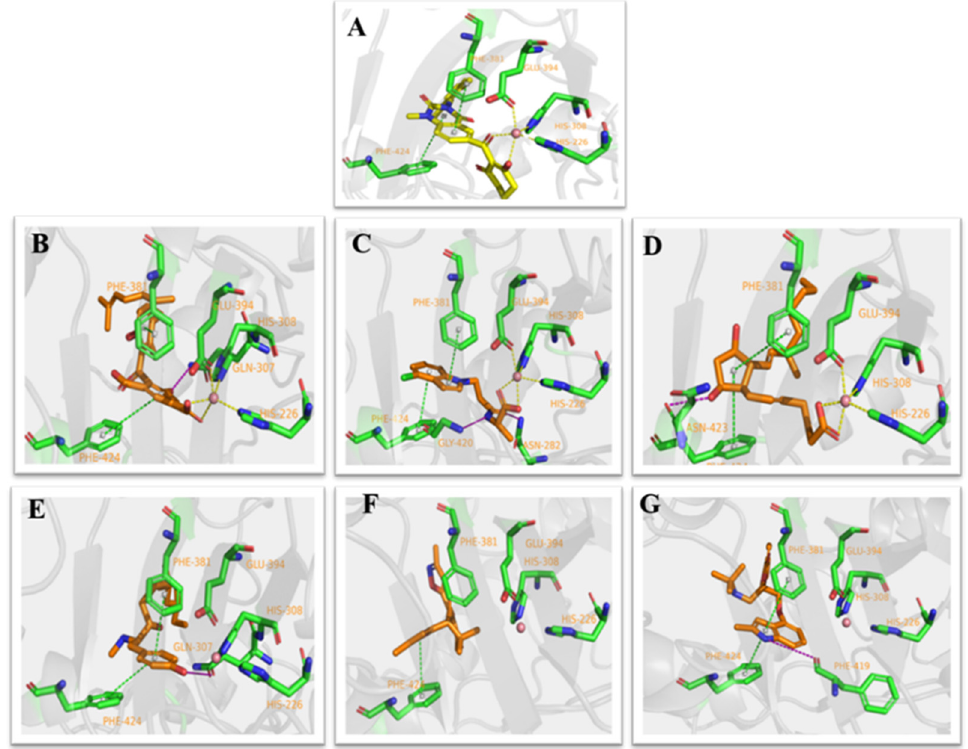
Figure 3. Receptor–ligand interaction of ( A ) benquitrione, ( B ) ZINC000049180836 ( C )